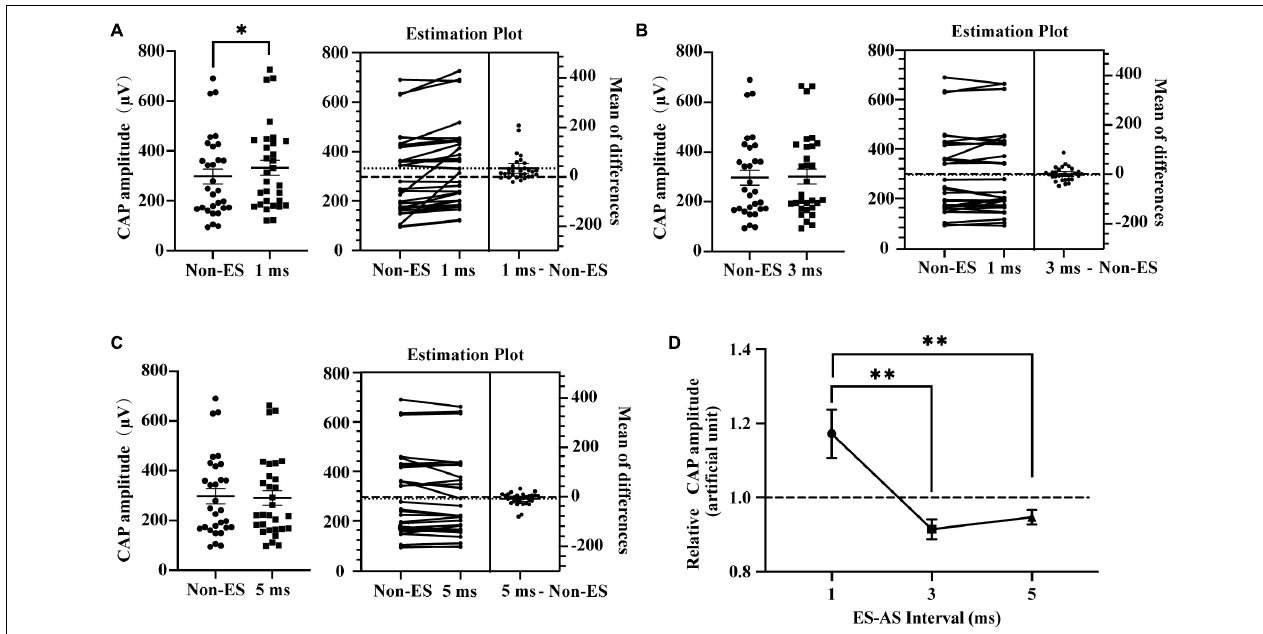
FIGURE 4 | Impact of ES-AS interval on forward ES-induced interference in iECochG of AS. (A) One-ms-forward 3 dB (double ECAP threshold intensity) ES with E1 significantly increased CAP amplitudes of 4 kHz/20 dB AS, P = 0.0041. (B,C) CAP amplitudes in groups with 3 and 5 ms-forward ES were comparable with that in a non-ES group, P = 0.4773 and 0.1294, respectively. In (A–C) each plot means an animal data and the horizontal line means the mean across animals. (D) Relative CAP amplitudes varied with interval between ES and AS, F (2,58) = 8.019, P = 0.0008. Relative CAP amplitudes of AS combined with 1 ms-forward ES were significantly higher than that with 3 or 5 ms-forward ES, P = 0.0015 and 0.0060, respectively, while that in the last two groups were comparable and inclined to be unit, P = 0.8887. (A–C) Treated with a two-tailed paired t test. (D) Treated with repeated measures (RM) one-way ANOVA with two-tail paired t test multiple comparison. ∗ P < 0.05; ∗∗ P <